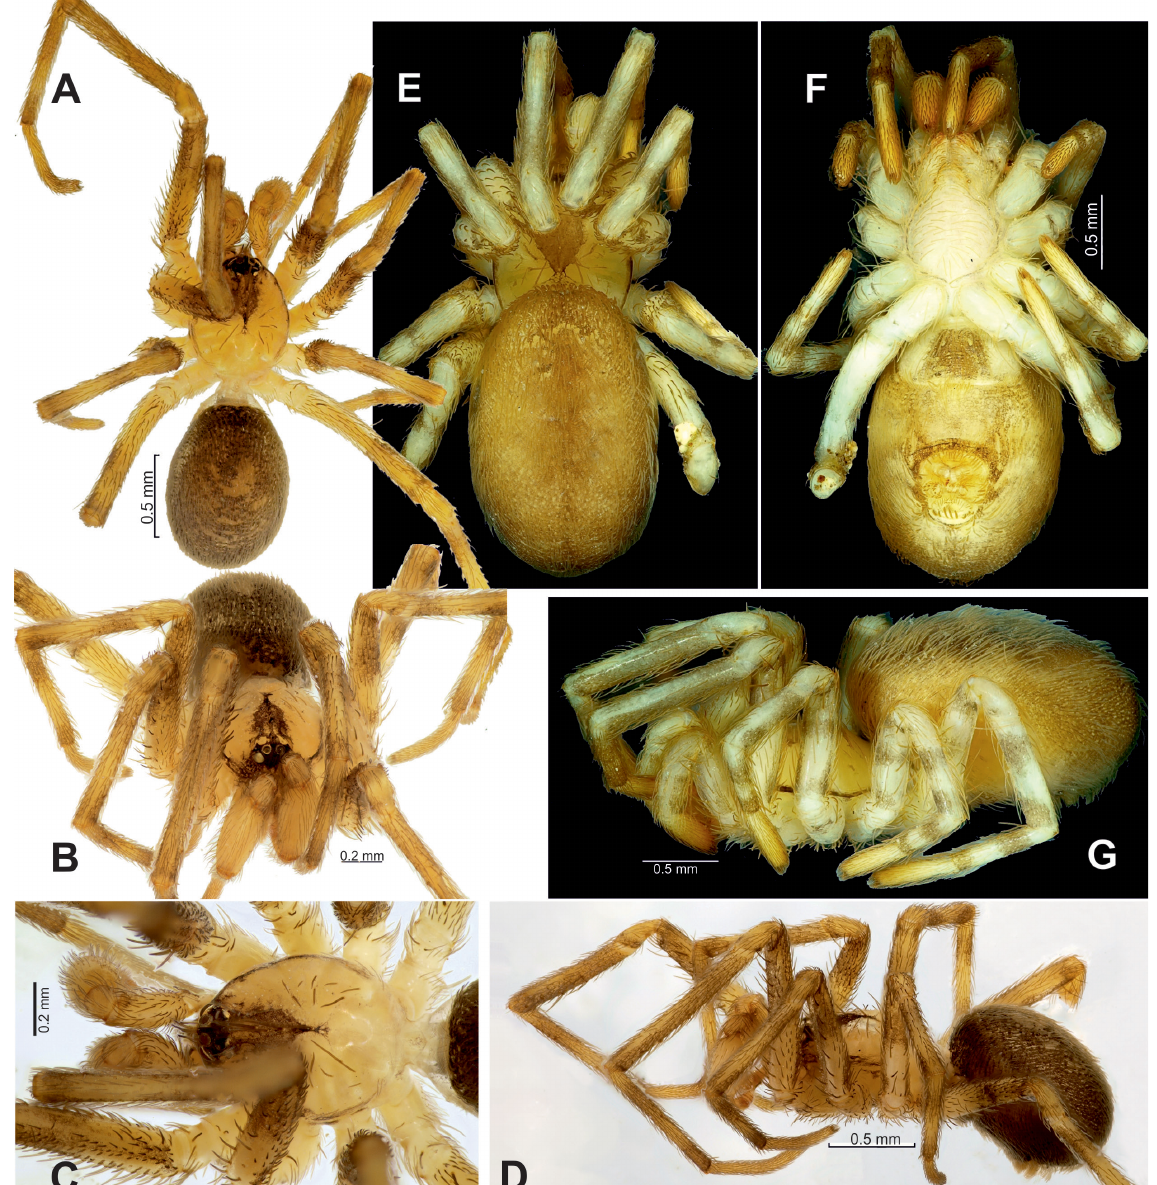
Fig. 8. Somatic characters of Zaitunia annulipes (Kulczyński, 1908), ♂ from Paramali ( A–D ) and ♀